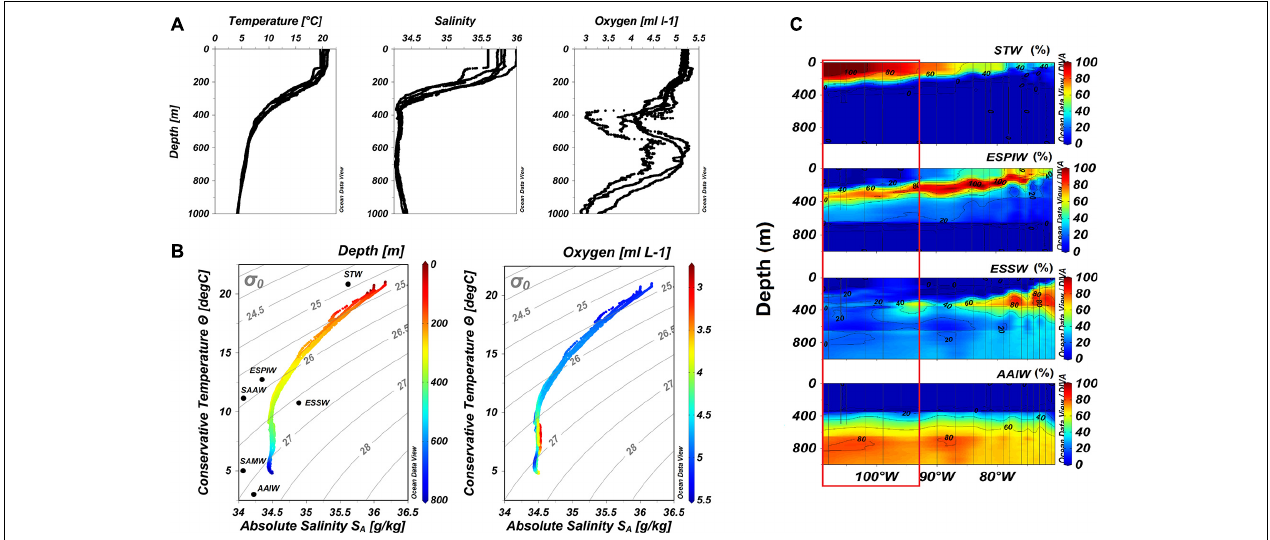
FIGURE 2 | Oceanographic characteristics in the SPSG and over the coastal-oceanic transect of the CIMAR-21 cruise showing the water masses contribution (%) in the Pacific Southeast, Chile, ( ∼ 27 ◦ S) during October and November of 2015. (A) Vertical profiles of temperature, salinity and oxygen of the water column in the SPSG (98–110 ◦ W). (B) T-S diagram in the SPSG (98–110 ◦ W), left by depth and right by oxygen concentration. (C) Contribution in percentage of water masses in the Pacific Southeast of Chile longitude 70–110 ◦ W; the red rectangle shows the study area in the longitude 98-110 ◦ W. Subtropical Water (STW), Eastern South Pacific Intermediate Water (ESPIW), Equatorial Subsurface Water (ESSW), Antarctic Intermediate Water